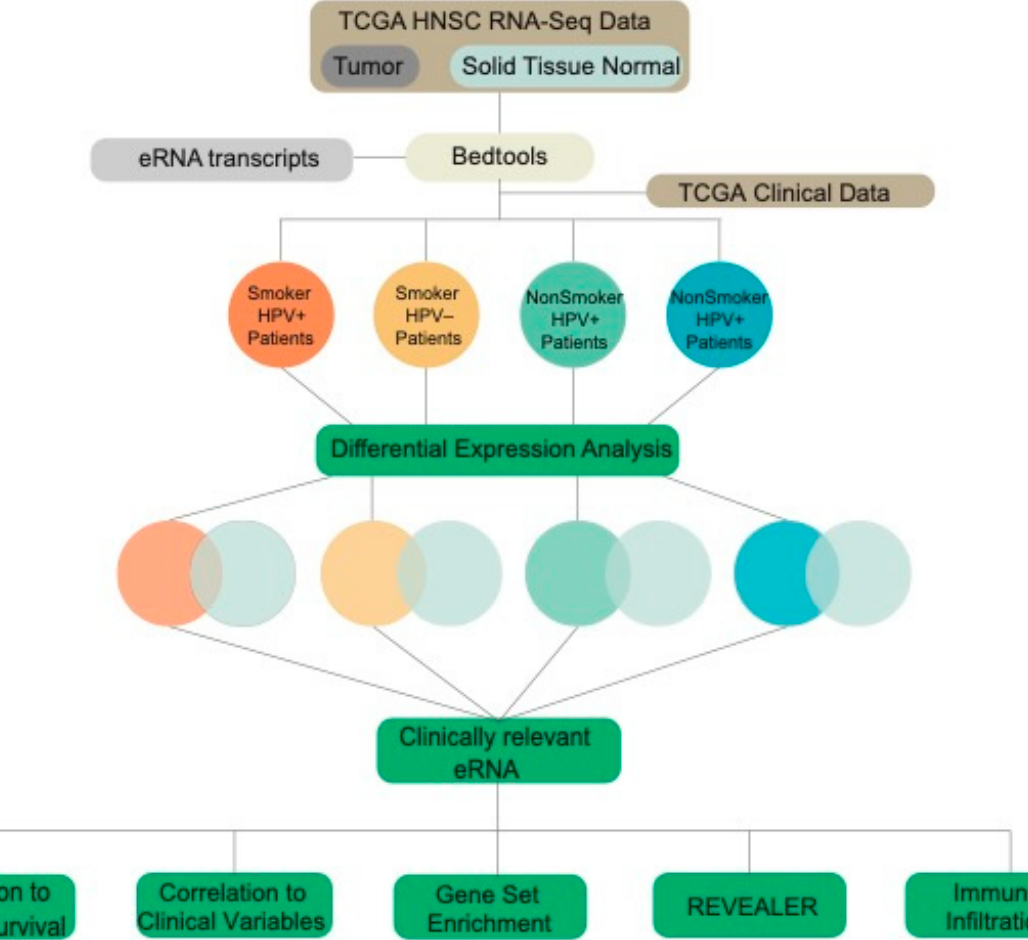
Figure 1. Schematic of the study’s workflow. Data were obtained from The Cancer Genome Atlas (TCGA) for Head and Neck Squamous Cell Carcinoma (HNSCC) tumor and solid tissue normal samples and separated into cohorts based on patient smoking and HPV status.